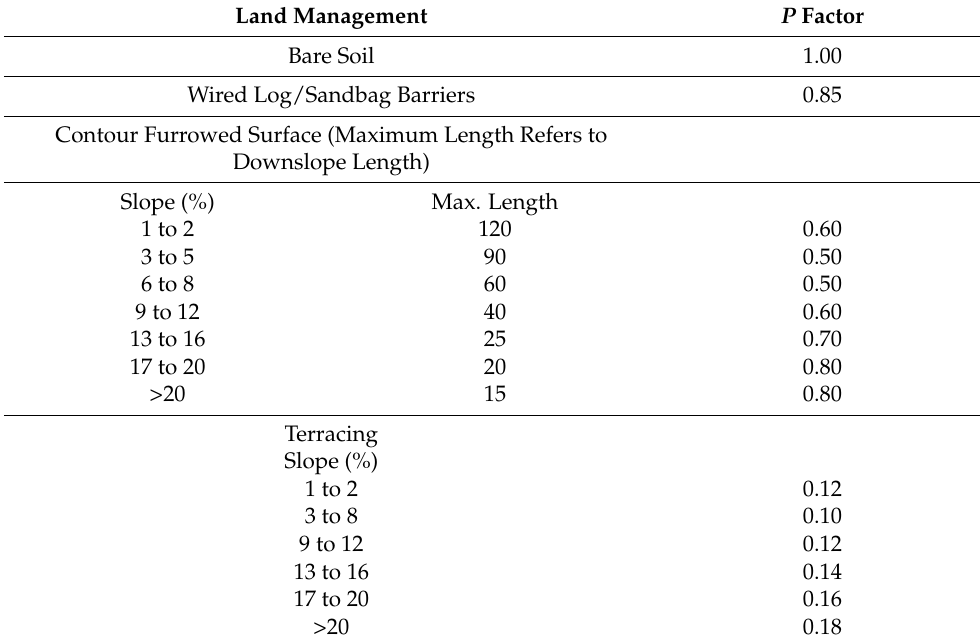
Table 3. Land Management, P Factor for BMPs for Construction/Developing Sites 1 (adapted from Refs.